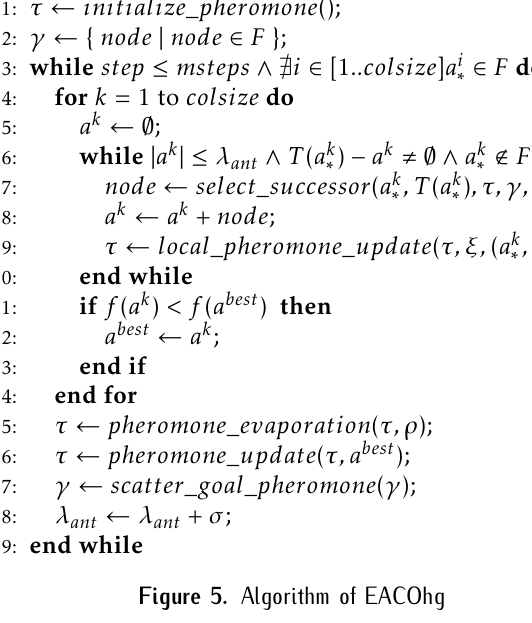
Figure 5. Algorithm of